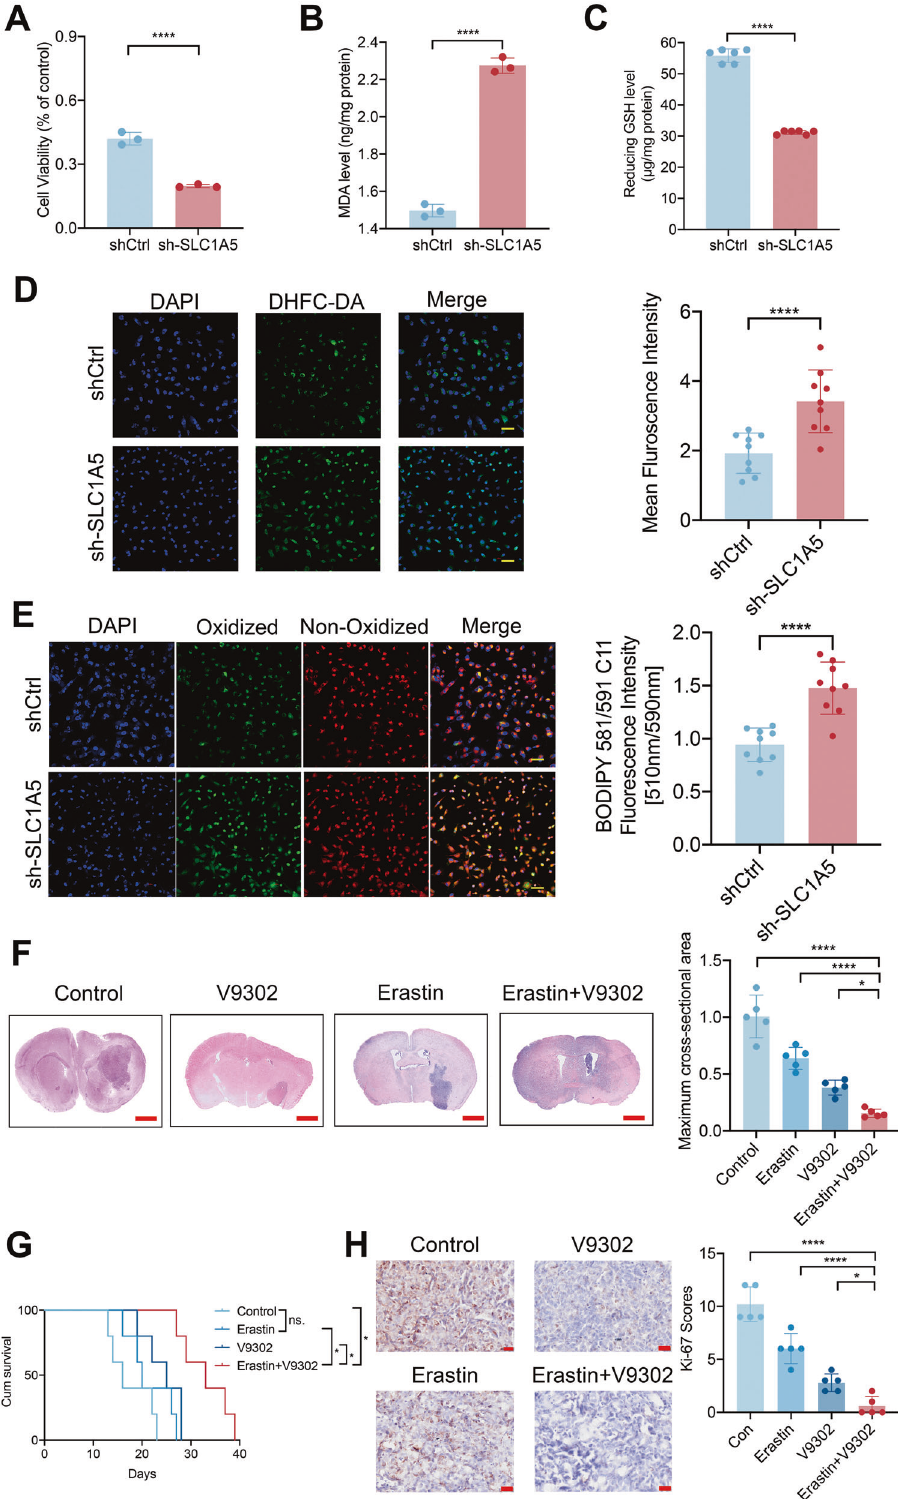
Fig. 5 SLC1A5 resisted cellular oxidative stress damage and ferroptosis state in glioma cells. A The CCK-8 assay results of cell viability after SLC1A5 knockdown with Erastin treatment. B The MDA level after SLC1A5 knockdown with Erastin treatment. C The level of reduced GSH after SLC1A5 knockdown with Erastin treatment. D The fl uorescence intensity of DHFC-DA (green) in SLC1A5 knockdown T98G cells with Erastin treatment (Scale Bar = 20 μ m). E The level of oxidized lipid peroxides(green) in SLC1A5 knockdown T98G cells with Erastin treatment (Scale Bar = 20 μ m). F The HE staining and the tumor size analysis in Erastin and V9302 separate and combined treatment groups (Scale Bar = 1 mm). G Kaplan – Meier survival curves of survival time in different treatment groups. H The Ki-67 IHC images and scores of glioma sections in different treatment groups (Scale Bar = 20 μ m).